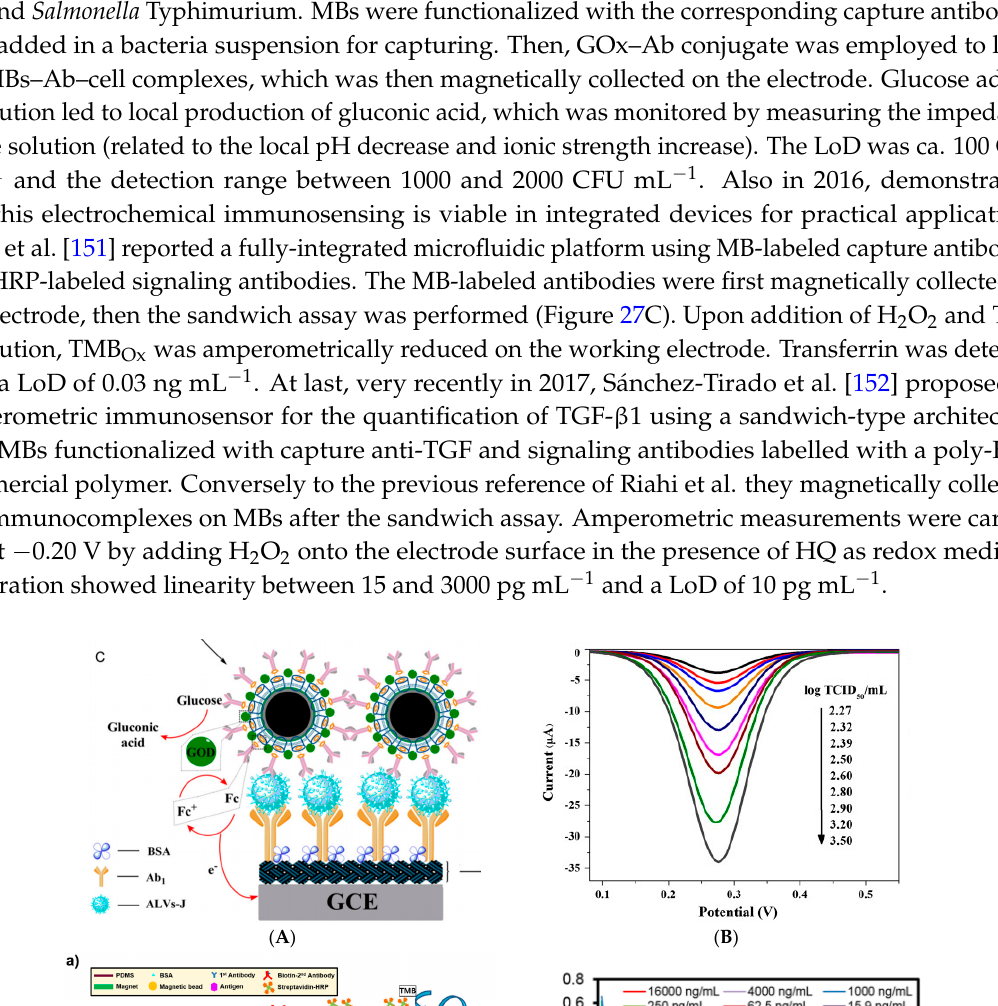
the chip with an integrated microelectrode; (ii) photograph of the microelectrode; (iii) photograph of the reaction chamber with oxidized TMB, (iv) transfer of oxidized TMB to the detection chamber; ( D ) Amperometry measurement at − 100 mV for different standard transferrin